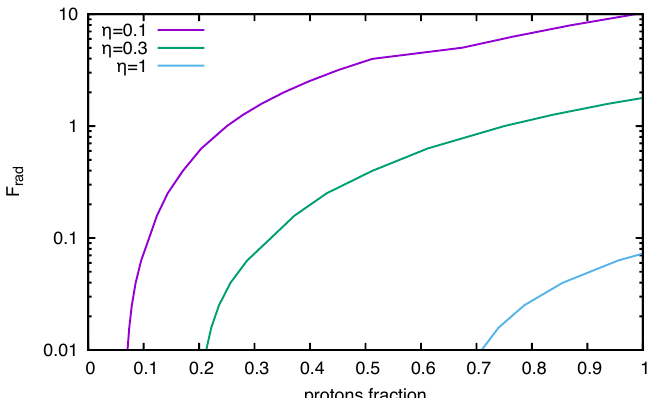
Figure 5. Upper limit on the EGRB, given as a factor F rad times the lower radio background prediction of Protheroe and Biermann [44], which could be achieved if a GZK photon flux is detected at a level η = 0.1 (magenta), η = 0.3 (green), and η = 1 (blue) of the present Auger UHECR photon limits [26,27], shown as function of the proton fraction in UHECRs (to be determined in the future by AugerPrime). The limits for other η values can be easily obtained since they scale linearly with η . The production of photons from primaries other than protons is neglected here (which would not be consistent with small proton fractions, close and below 0.1). The source model parameters assumed are α = 0, E max = 10 20 eV, m = 0, z max = 2, z min = 0. F rad = 10 corresponds to the ARCADE-2 measurement [1]. Notice that for a particular value of F rad , the corresponding proton fraction for a particular η is the minimum proton fraction compatible with the photon observation at the level indicated by η